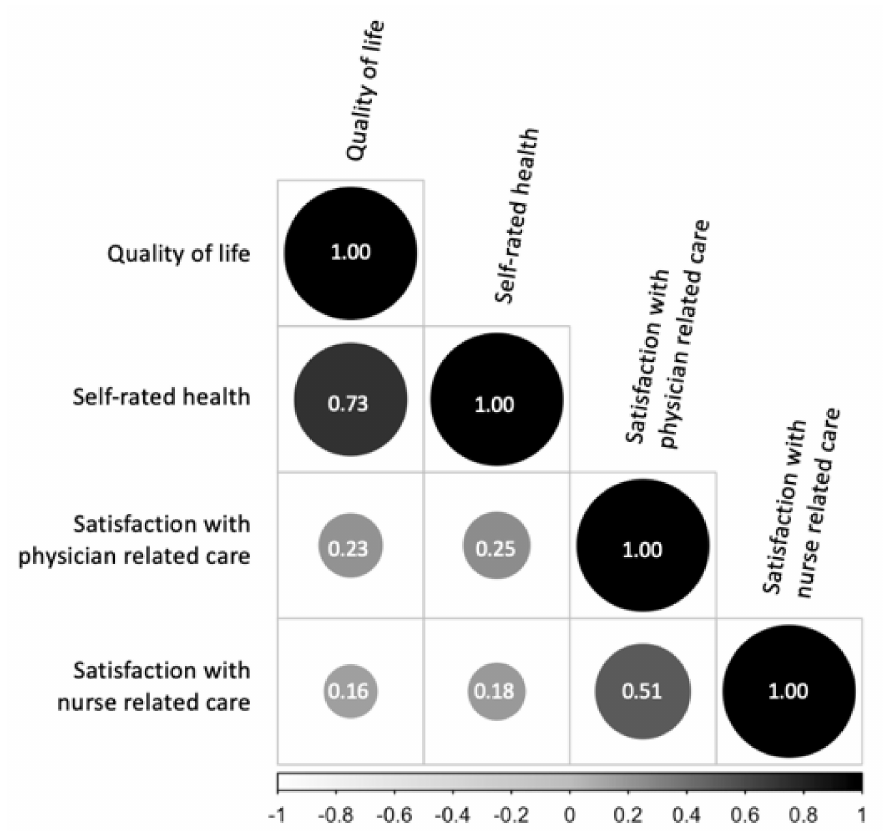
Figure 1. Visualization of the Spearman correlation coefficients of our variables of interest. Table 2. Multiple linear regression with adjustments for age, gender, mother tongue, and treating